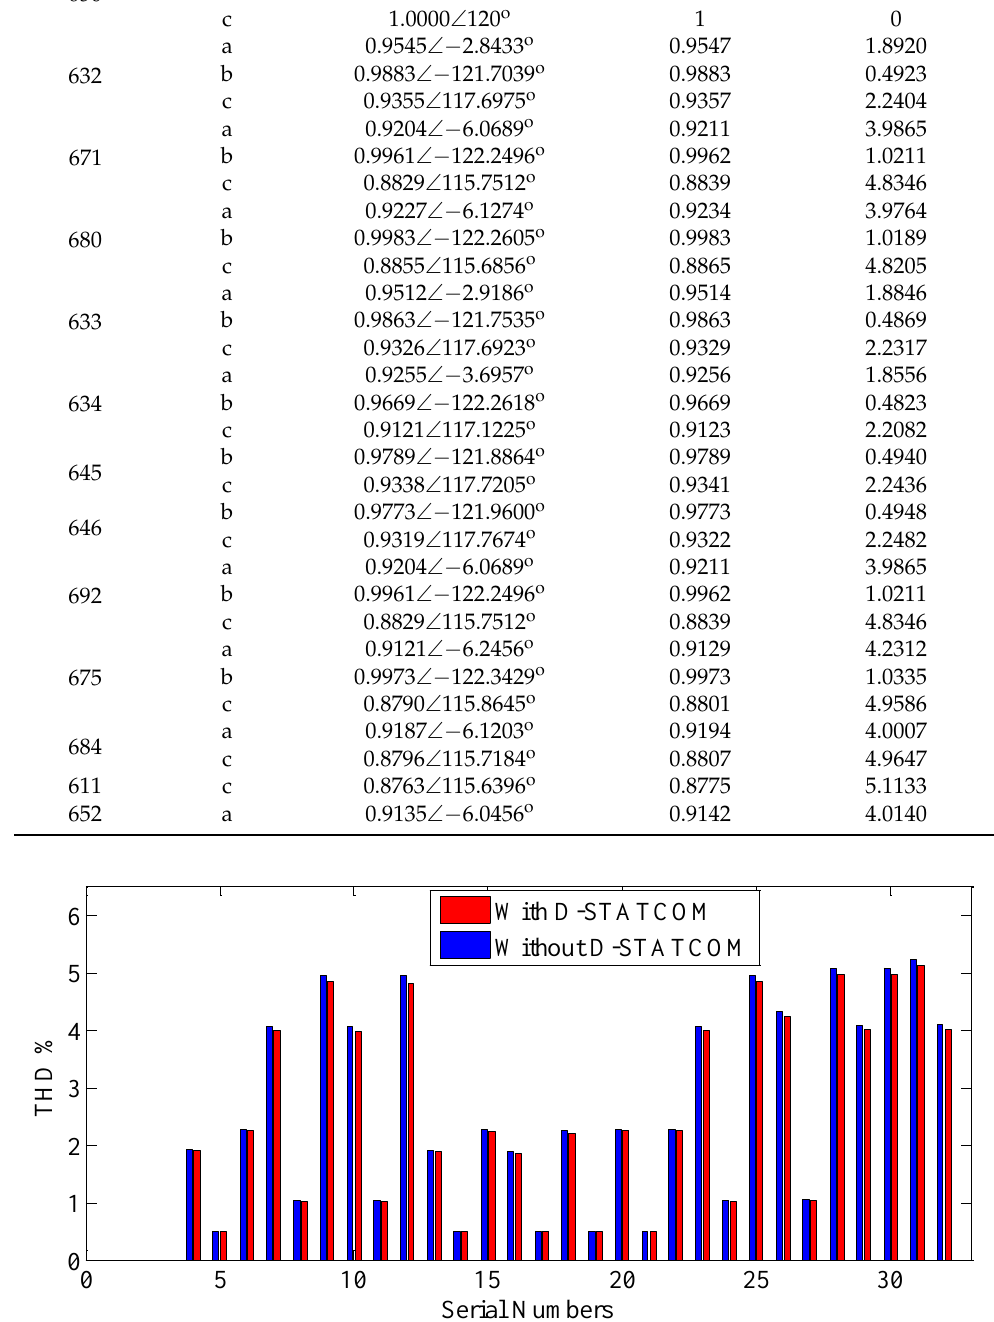
Figure 9. Comparison of fundamental r.m.svoltages for case studies on IEEE−13 URDN . 5.2. IEEE−34 Bus URDN The date for the IEEE−34 bus URDN is taken from [31]. The base values selected for the system are 2500 kVA and 24.9 kV. The load composition at spot loads for harmonic analysis is presented in Table 10. The data for the current spectra of harmonic loads are- taken from [32].The convergence tolerance for both fundamental and harmonic power flows is 10 −4 . The case studies on the network are presented in Table 11.The rating and location of the D-STATCOM device for Case2 is presented in Table 11. Table 12 presents the fundamental r.m.s voltage profile, the total r.m.s voltage profile, and the THD % for Case1. The test results of Case1 are used as a benchmark to see the fundamental and harmonic impacts of D-STATCOM on the network. The summary of results for the case studies is presented in Table 13. In Case2, which has integrations of two D-STATCOM devices, the maximum THD% is observed to be 5.2567 which is less than in Case 1. The number of phases effected with a THD% more than fiveis reduced from fourto twofrom Case 1 to Case 2. From Case 1 to Case 2, it is found that the minimum fundamental voltage on the network is improved from 0.7641 p.u to 0.8137p.u at bus 890 for the a-phase.The fundamental power loss and the total power loss including harmonic loss of the network reduced in Case 2 in comparison with Case 1. Figure 10 shows the compar-